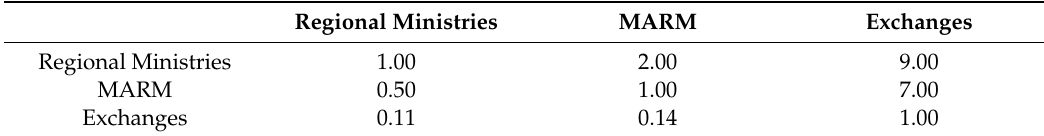
Table 8. Pairwise comparisons matrix.